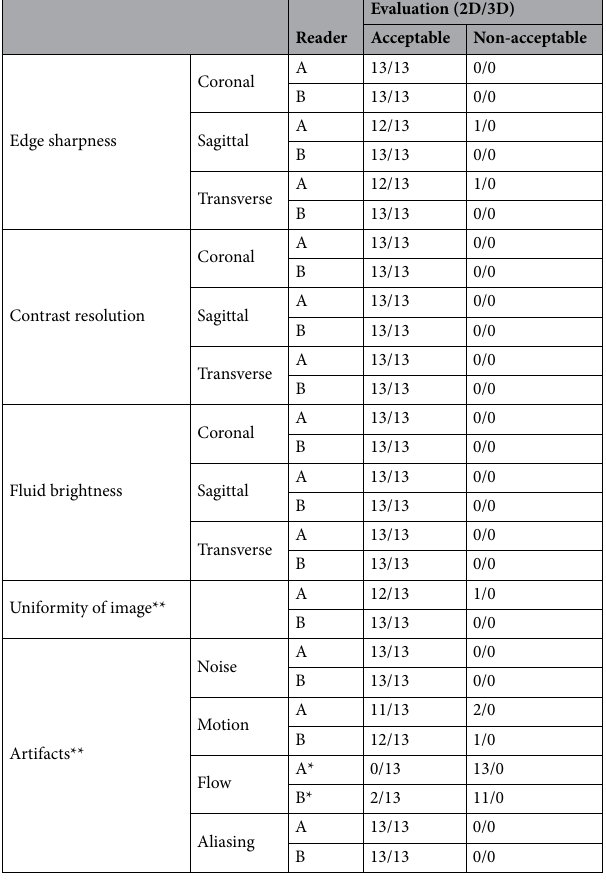
Table 2. Evaluation of image quality and artifacts of thin-slice 2D FS-PDWI and 3D FS-PD MPV image by two readers. Acceptable, scores 3, 4 and 5; Non-acceptable, scores 1 and 2. Coronal and sagittal images